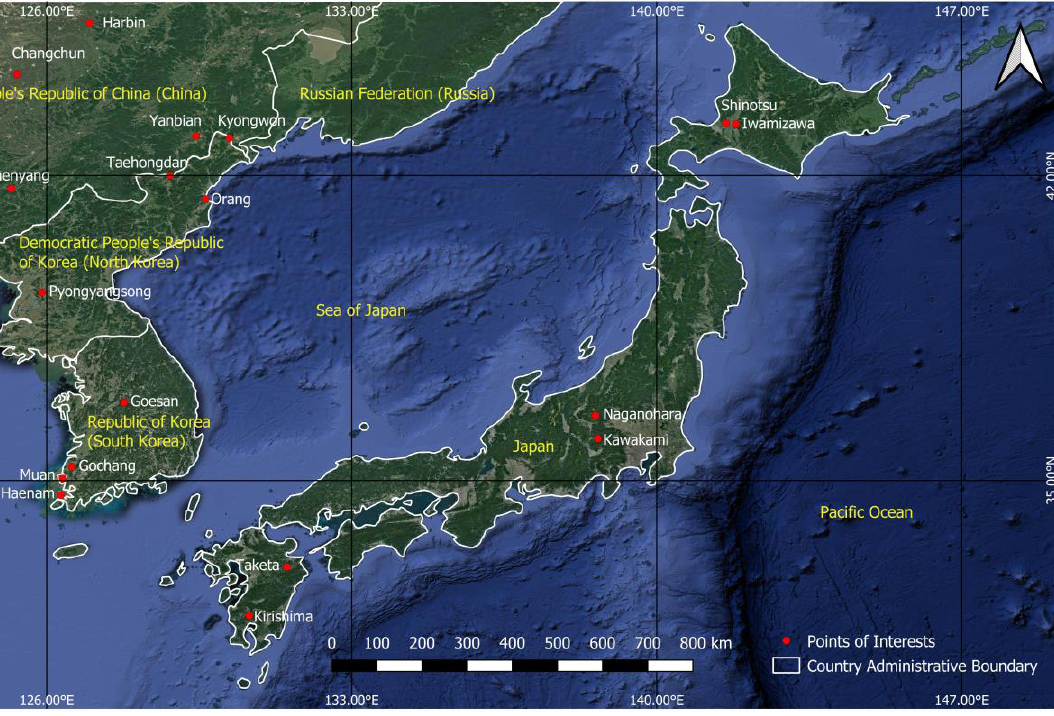
Table 1. Details of input datasets.